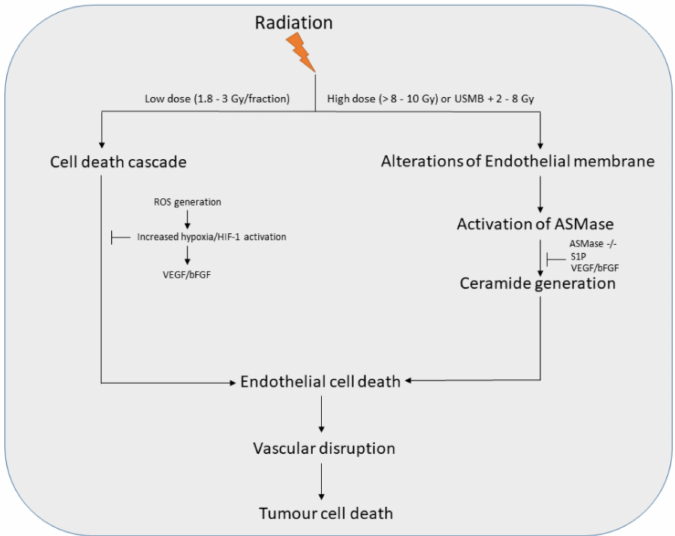
Figure 1. The low dose (1.8–3 Gy/fraction) induces the generation of ROS by hypoxia/reoxygenation that takes place following each exposure to radiation dose. This leads to the activation of HIF-1 which further generates several proangiogenic factors like VEGF or bFGF that debilitate radiation-induced endothelial cell apoptosis. However, inhibiting HIF-1 activity causes vascular radiosensitization resulting in tumour cell death. Exposure to a single high dose of radiation (>8–10 Gy) activates ASMase in endothelial cells to generate the secondary messenger ceramide. Ceramide accumu- lation in the plasma membrane facilitates apoptosis within endothelial cells, resulting in massive vascular disruption and subsequently leading to tumour cell death. USMB combined with low dose XRT elicits a similar effect as a single high dose. The addition of USMB to XRT is capa- ble of activating ASMase/ceramide pathway resulting in endothelial cell apoptosis. This causes damage to tumour vasculature further leading to tumour cell death. Abbreviations: HIF-1 = hypoxia- inducible factor-1; bFGF = basic fibroblast growth factor; VEGF = vascular endothelial growth factor; USMB = ultrasound-stimulated microbubbles; XRT =